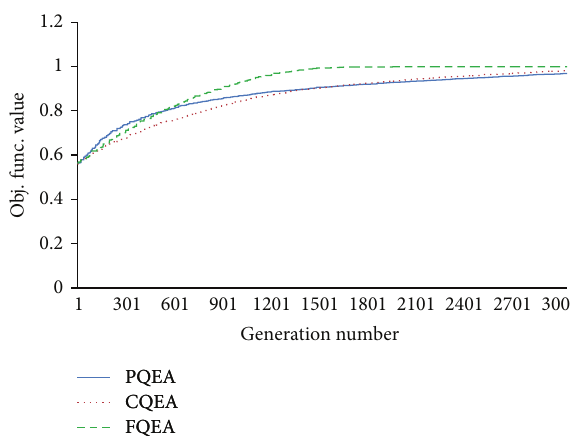
Figure 17: Convergence graph of PQEA, CQEA, and FQEA on 𝑃 - PEAKS problem of size, 𝑁 , being 1000 and number of peaks, 𝑃 , being 500.